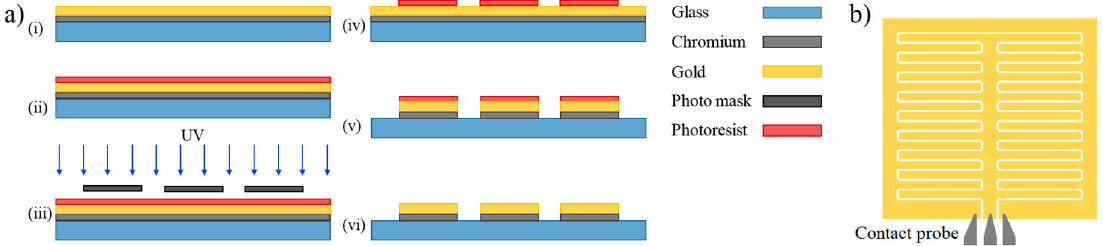
Figure 1. The fabricated interdigitated capacitive based biosensor. ( a ) Fabrication steps, ( b ) Layout of the IDE sensing electrodes and the schematic of the contact probe.